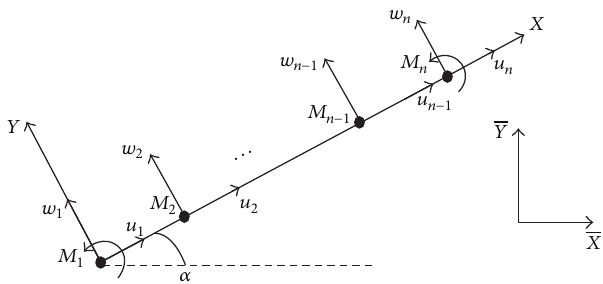
Figure3:Thesolvingdomainandnodesdisplacementofplanerigid frame.